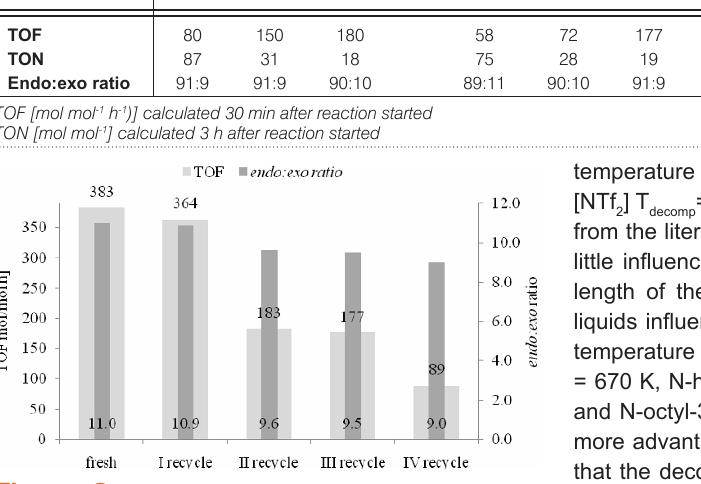
Figure 2. The effect of number of recycle runs on TOF values and endo:exo ratios